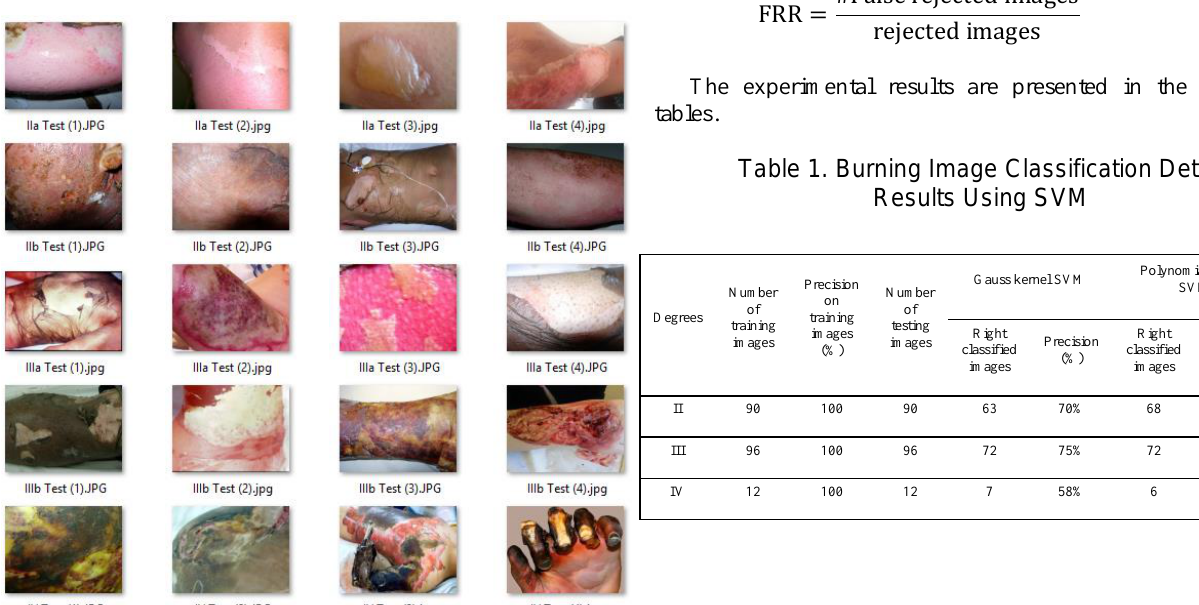
Fig. 15. Some images in training folder.